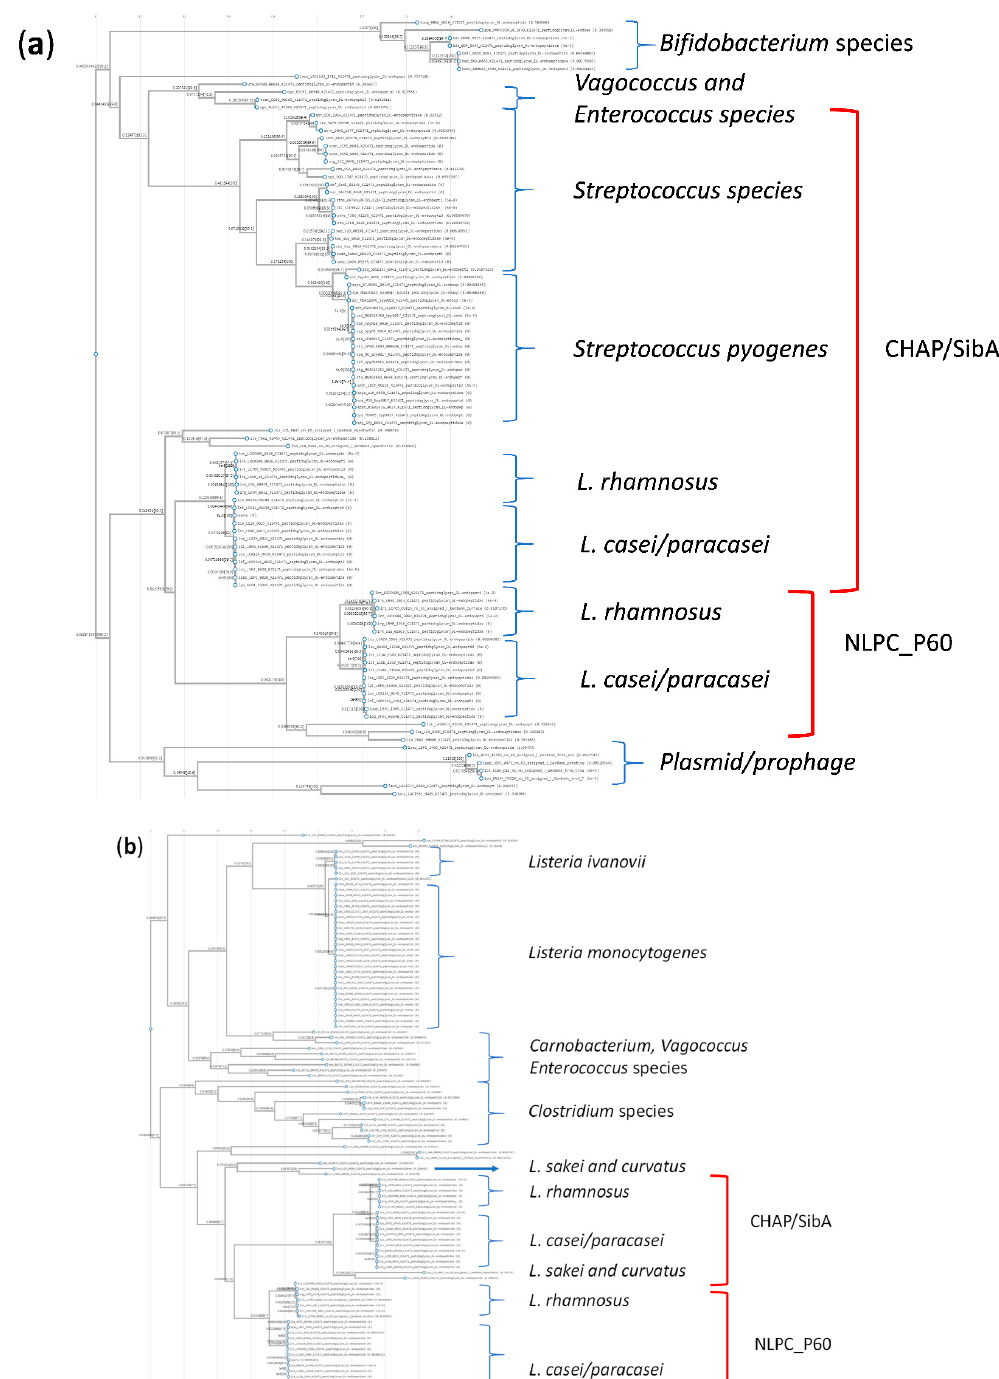
Figure 5. Mid-point rooted phylograms for top 100 aligned proteins for ( a ) query sequence of CHAP/SibA-domain protein (equivalent to gene locus BN194_00240) and ( b ) query sequence NLPC_P60 domain (equivalent to gene locus BN194_21500) protein from L. casei GCRL 163. 2.7. The Predicted Protein Structural Models Differentiate Between the Two Endopeptidase Types in L. casei Group Strains